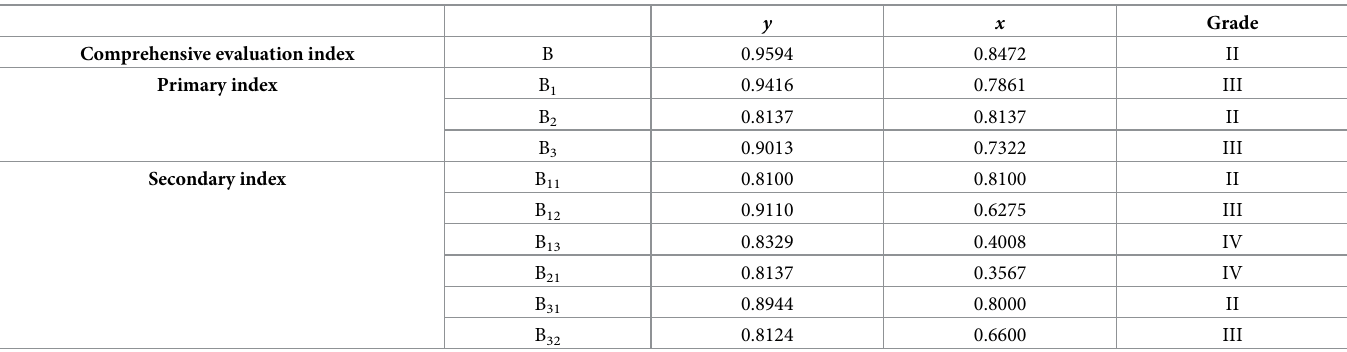
Table 15. Evaluation results of the feasibility of the brownfield redevelopment